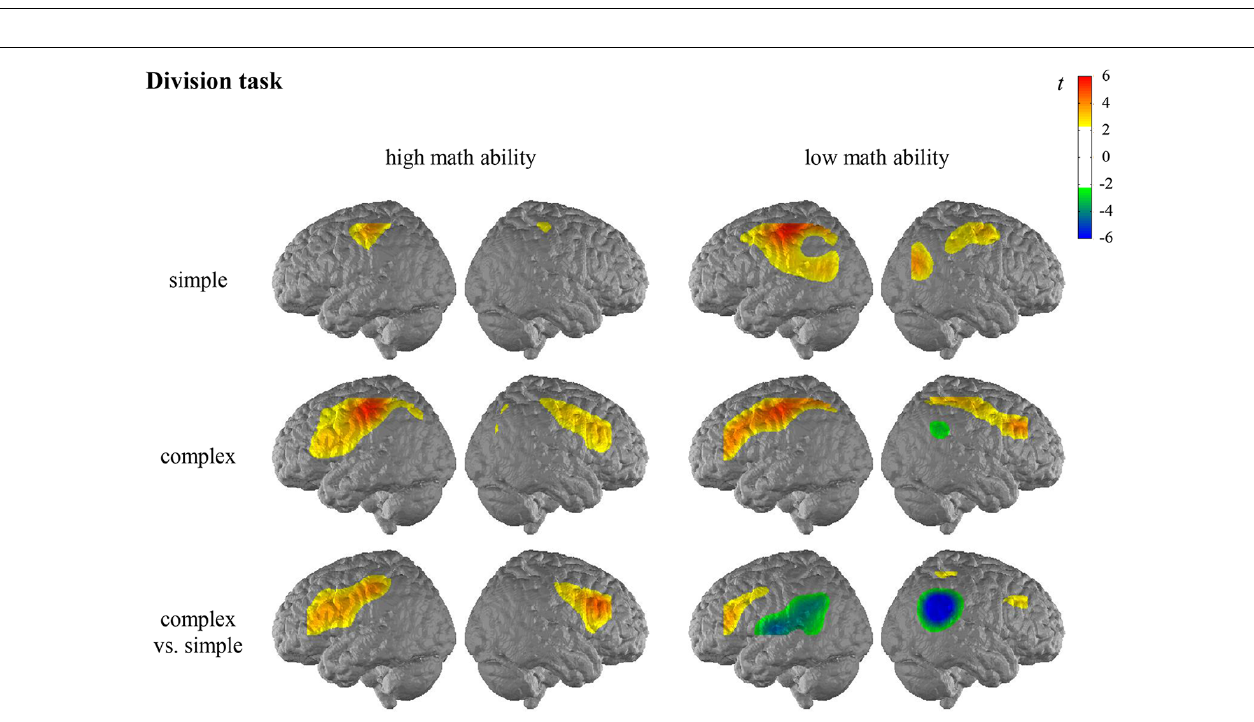
FIGURE 3 | T maps for the fNIRS data depicting neural activation during the division task for simple arithmetic problems, complex arithmetic problems and the contrast (complex vs. simple) for individuals with high math ability and low math ability. The colors indicate activation (yellow-red) and deactivation (green-blue),